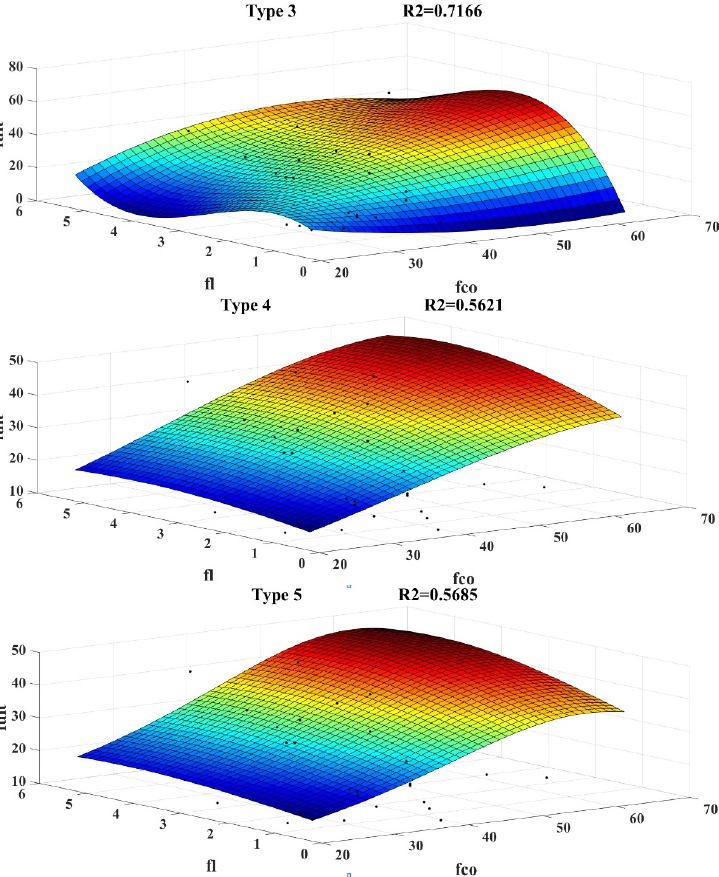
Figure 13. Regression analysis diagrams of the three-dimensional equations for predicting the ultimate compressive strength of the SMA-confined concrete cylindrical specimens and comparing them with the experimental data.